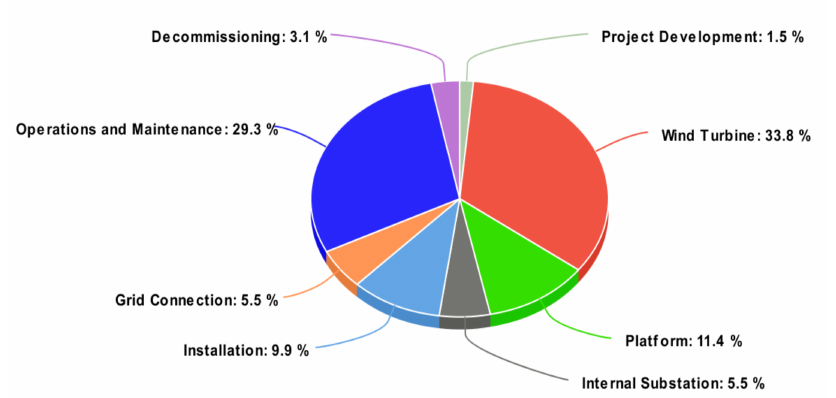
Figure 4. Cost Estimation for Offshore Wind Projects based on data from